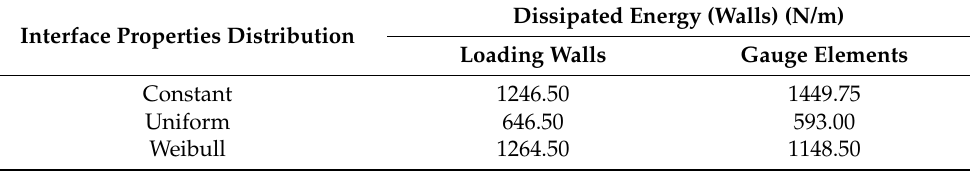
Table 4. Dissipated energies determined from the stress–strain curves recorded from loading walls and gauge